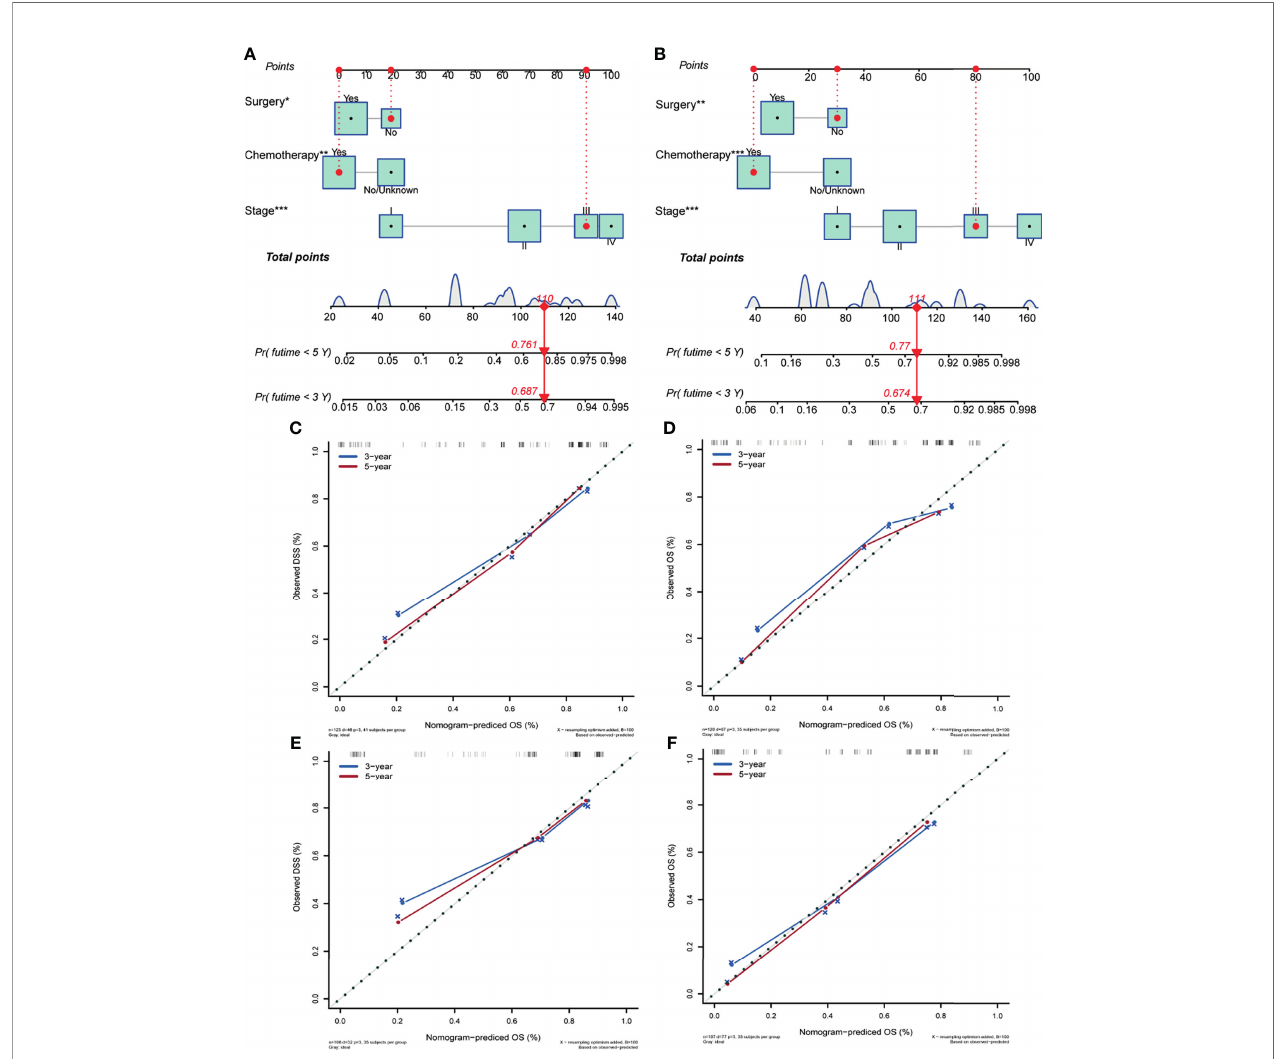
FIGURE 4 | Nomogram predicting the disease-speci fi c survival (A) and overall survival (B) of patients with initially diagnosed small cell carcinoma of the breast. Calibration plots in the training (C, D) and validation (E, F) cohorts for 3- and 5-year disease-speci fi c survival and overall survival. Signi fi cant differences are de fi ned by *p < 0.05, **p < 0.01, and ***p <